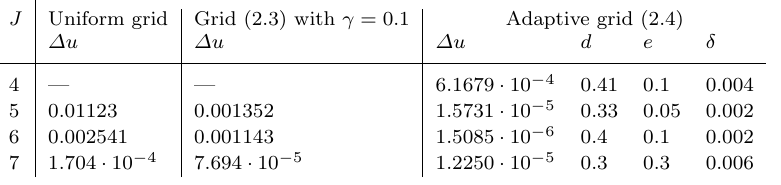
Table 5. Maximal deviation from the exact solution ∆u against resolution J in the case of the sine-Gordon equation with c = 1 − 5 · 10 − 5 and x 0 = 0 . 3, t f = 1 − 2 x 0 J N Uniform grid Grid (2.3) with γ = 0 . 1 Adaptive grid (2.4) ∆u